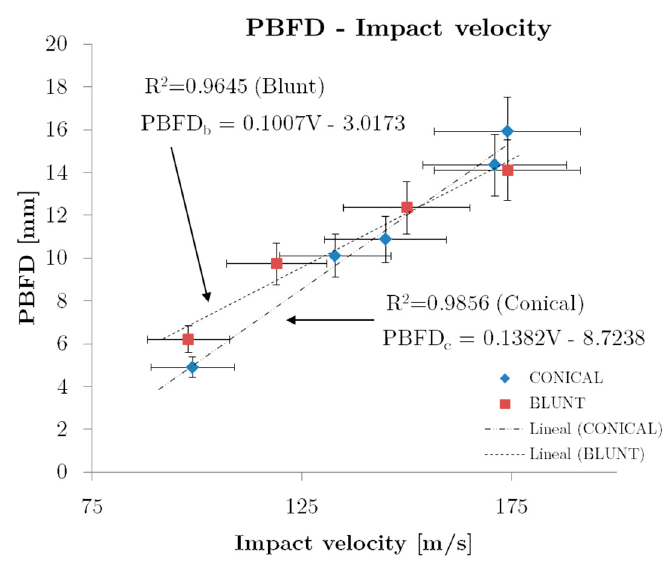
Figure 13. Back Face Deformation—Impact velocity correlation.